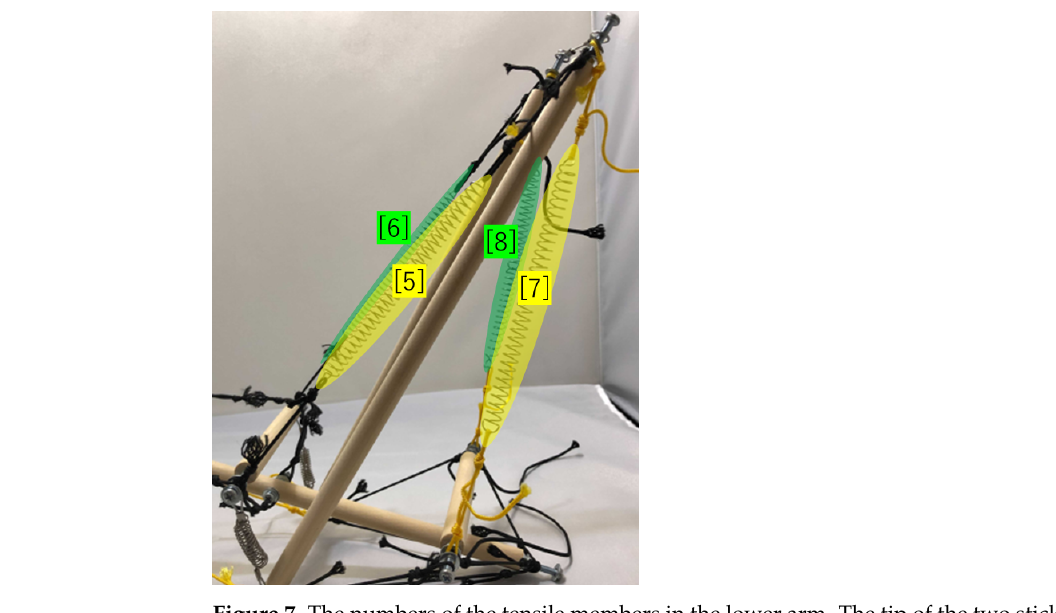
Figure 7. The numbers of the tensile members in the lower arm. The tip of the two sticks is connected by No. 19 wire shown in Figure 8. In this figure, the tensile member inside the elbow at the front of the lower arm is No. 5; the member inside the elbow at the back is No. 6; the member outside the elbow at the front is No. 7; and the member outside the elbow at the back is named No. 8. They are color-coded yellow and green to make them easier to see.